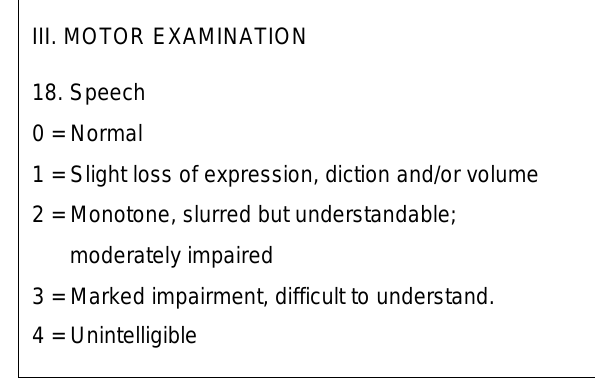
Table 2. Unified Parkinson’s Disease Rating Scale (Fahn et al.,